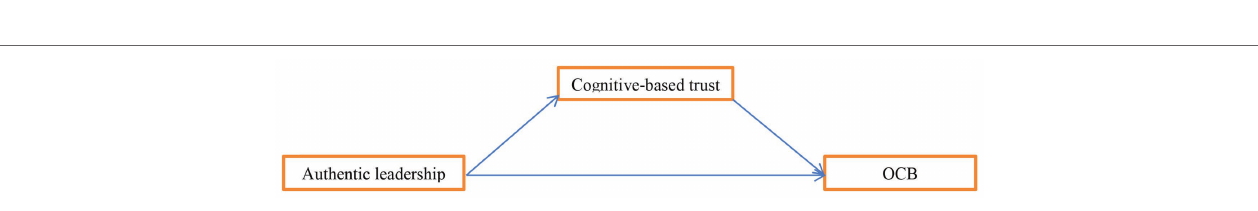
FIGURE 1 | The relationship between authentic leadership and organizational citizenship behaviors (OCBs), authentic leadership, and affective-based trust, affective-based trust, and OCBs, as well as the mediating effect of affective-based trust on the relationship between authentic leadership and OCBs.